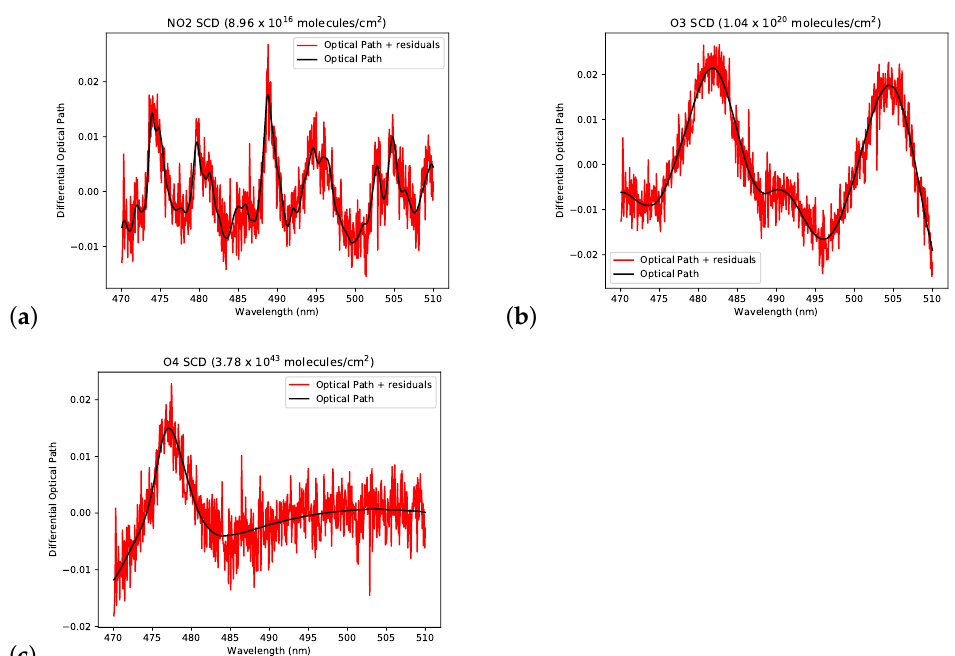
Figure 4. Examples of differential optical paths due to NO 2 ( a ), O 3 ( b ) and O 4 ( c ) absorption, fitted by QDOAS for a spectrum acquired in 6 July 2017 at 19:11 UTC when the SZA was 89.3 ◦ . SCDs values are reported in the plots’